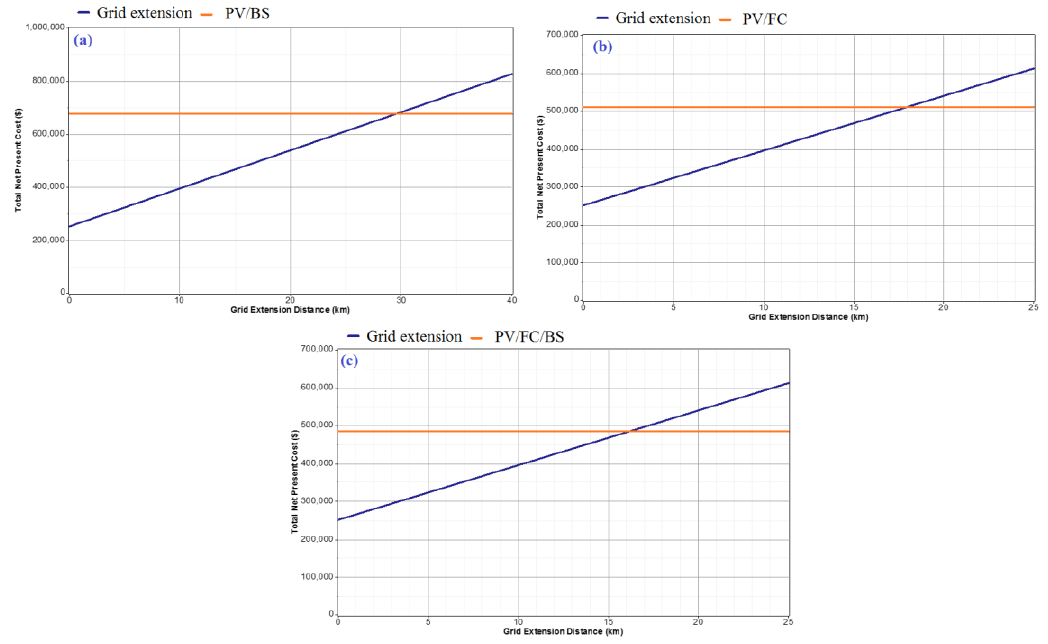
Figure 16. Breakeven grid extension distance for different systems; (a) PV/BS system. ( b ) PV/FC ( c ) PV/FC/BS.